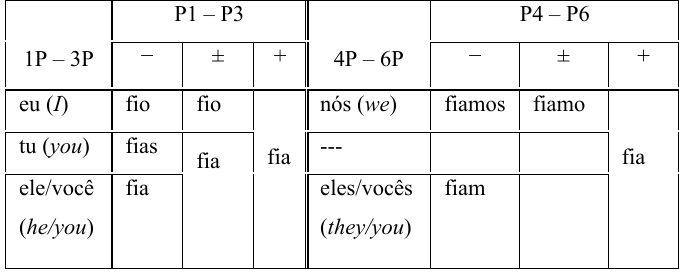
Table 2 – Degrees of markdness on the indicative present paradigm P1 – P3 P4 –